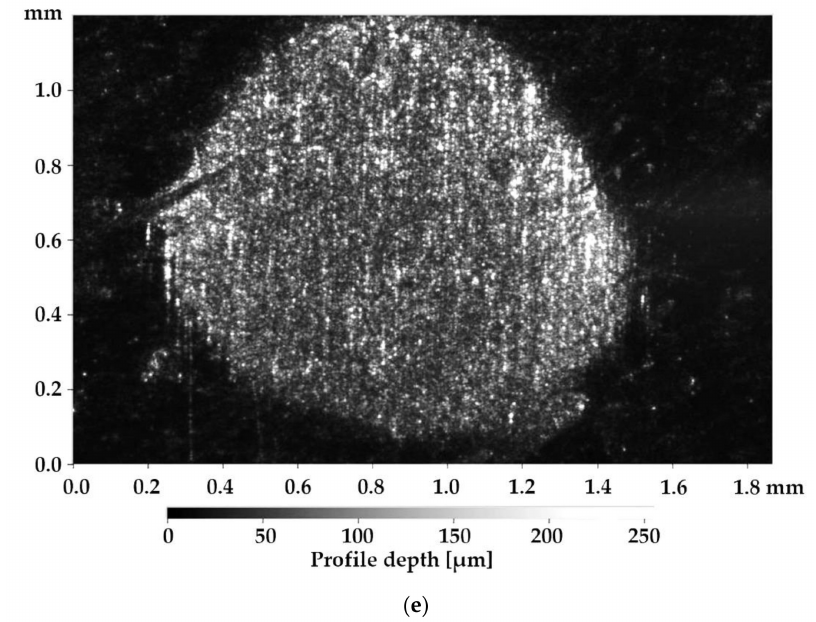
Figure 8. Profiles and microphotographs of the wells of the steel samples after 4 min of abrasive wear: ( a ) well image of 20Kh13 (DIN 1.4021) steel sample after processing; ( b ) well image of 20Kh13 (DIN 1.4021) steel sample after cavitation-abrasive finishing; ( c ) well image of 20Kh13 (DIN 1.4021) steel sample after plastic deformation; ( d ) well image of 12Kh18N9T (DIN 1.4541) steel sample after processing; ( e ) well image of 12Kh18N9T (DIN 1.4541) steel sample after vibratory tumbling.